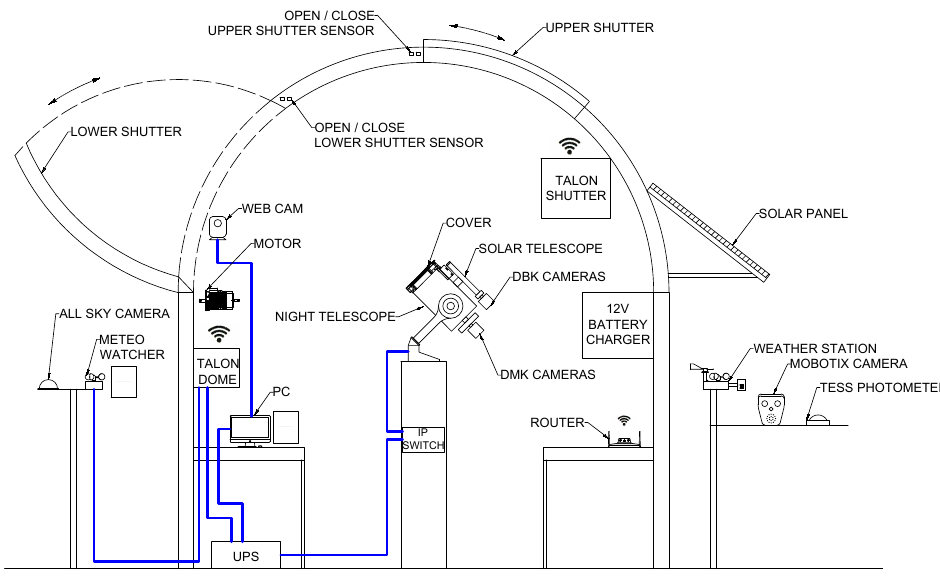
Figure 1. Diagram of the OFS’s (Francisco Sanchez Observatory, from the acronym in Spanish)